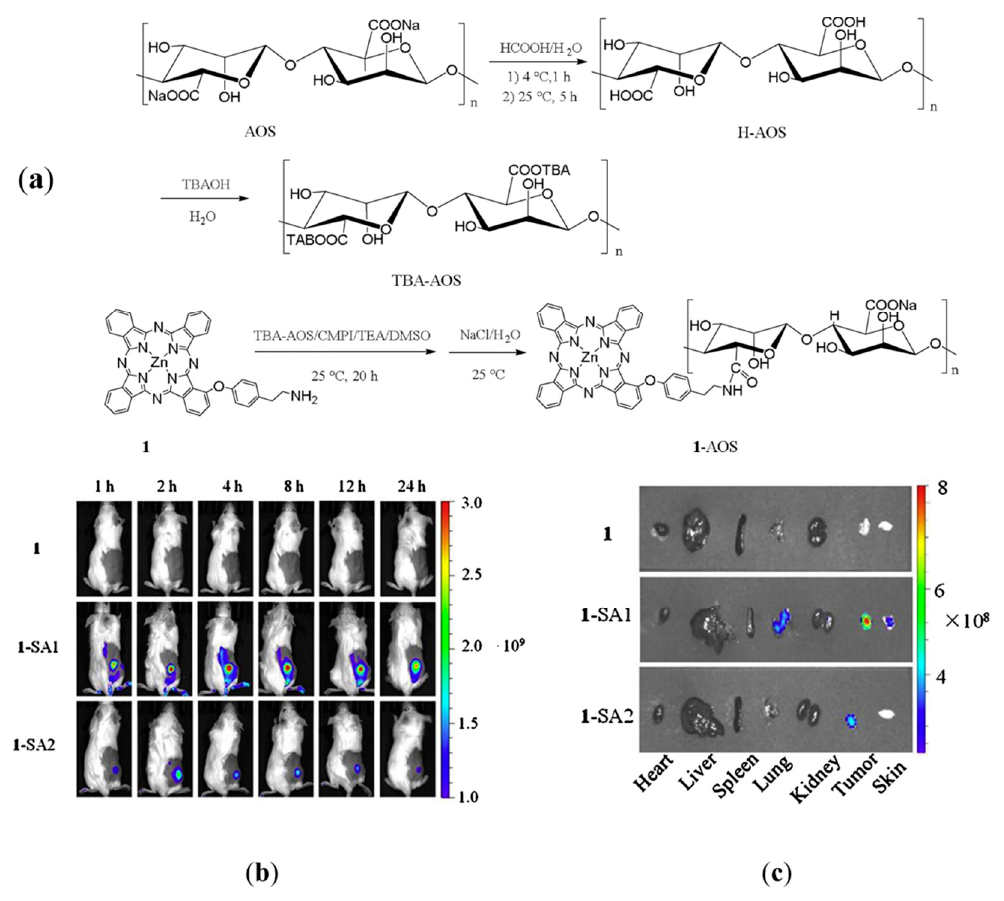
Figure 9. ( a ) Schematic diagram of the design and synthesis of a novel conjugation vehicle of a photosensitizer based on sodium alginate (SA). ( b ) In vivo fluorescence images of tumor-bearing KM mice after intravenous injection of SA-based carriers with different molecular weights. The red area represents tumor sites. ( c ) Ex vivo fluorescence images of organs and tumor at 24 h after injection of SA-based carriers with different molecular weights (1-SA1 is low-molecular-weight SA-based carriers). Modified from [106].